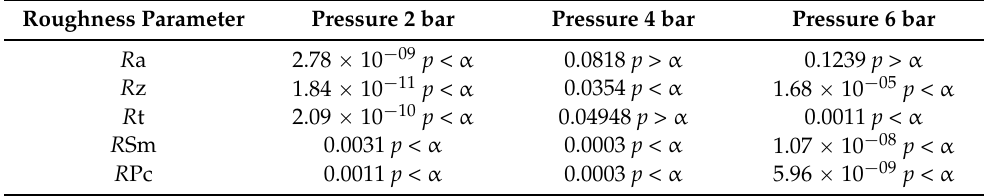
Table 8. p -Values at different